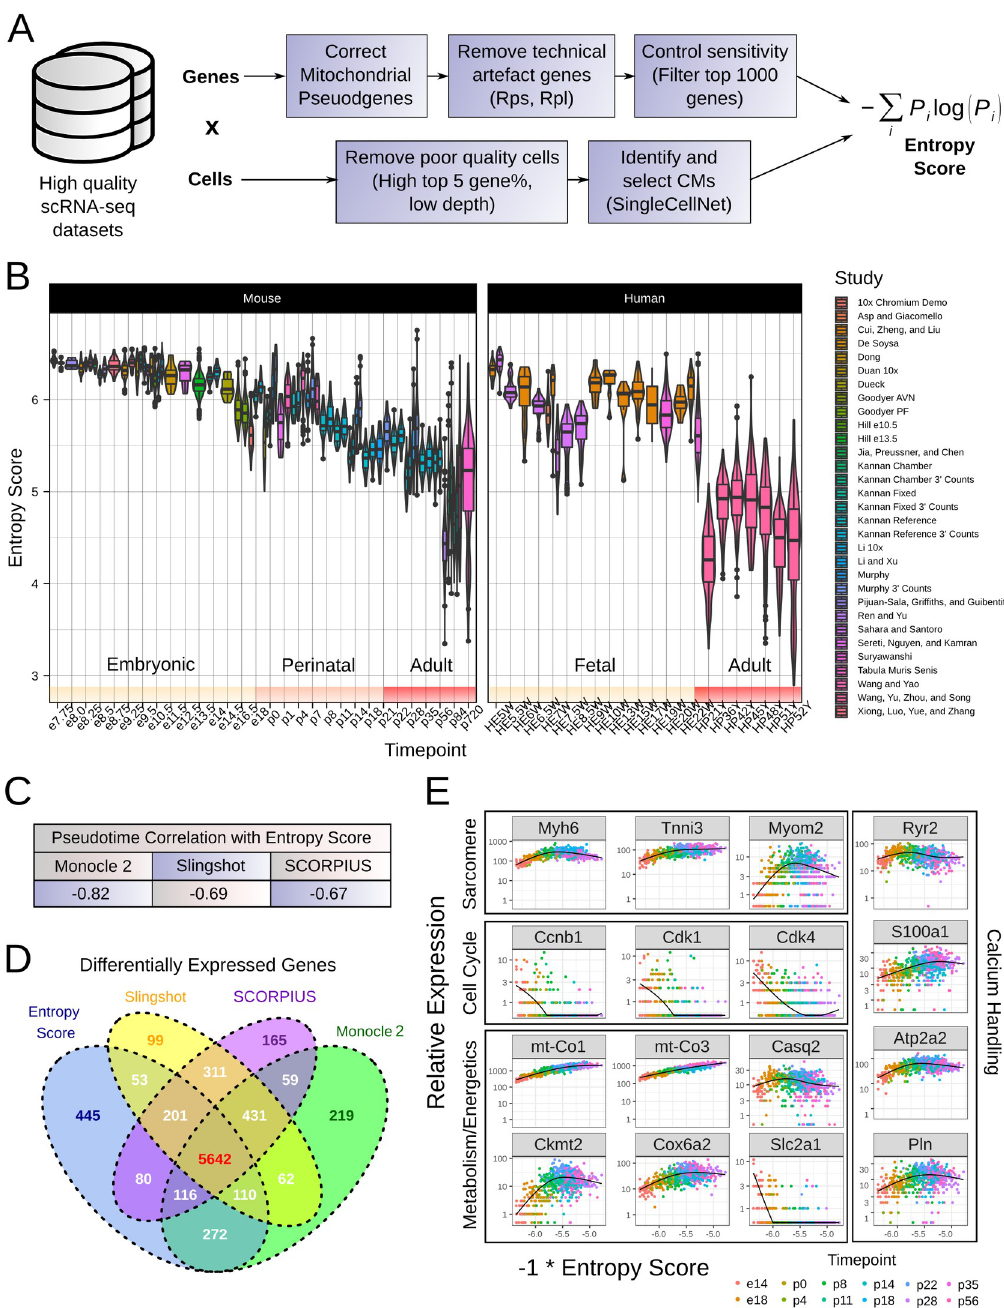
Fig 4. Entropy score enables cross-study and cross-species comparison of CM maturation status, and recapitulates gene trends in CM maturation. A. Workflow for computing entropy score from high quality scRNA-seq datasets. B. Entropy score for mouse and human in vivo CMs taken from publicly available datasets. HEW = human embryonic week, HPY = human postnatal year. C. Pearson correlation between entropy score and calculated pseudotimes for our maturation reference dataset for three trajectory inference methods: Monocle 2, Slingshot, and SCORPIUS. D. Venn diagram showing overlap in identified differentially expressed genes between entropy score and trajectory inference methods. Differentially expressed genes were identified by fitting generalized additive models to gene trends over the corresponding pseudotime in Monocle 2, and selecting genes with adjusted p-value < 0.05. E. Gene expression trends over entropy score for genes involved in CM maturation, including sarcomeric, cell cycle, metabolism, and calcium handling